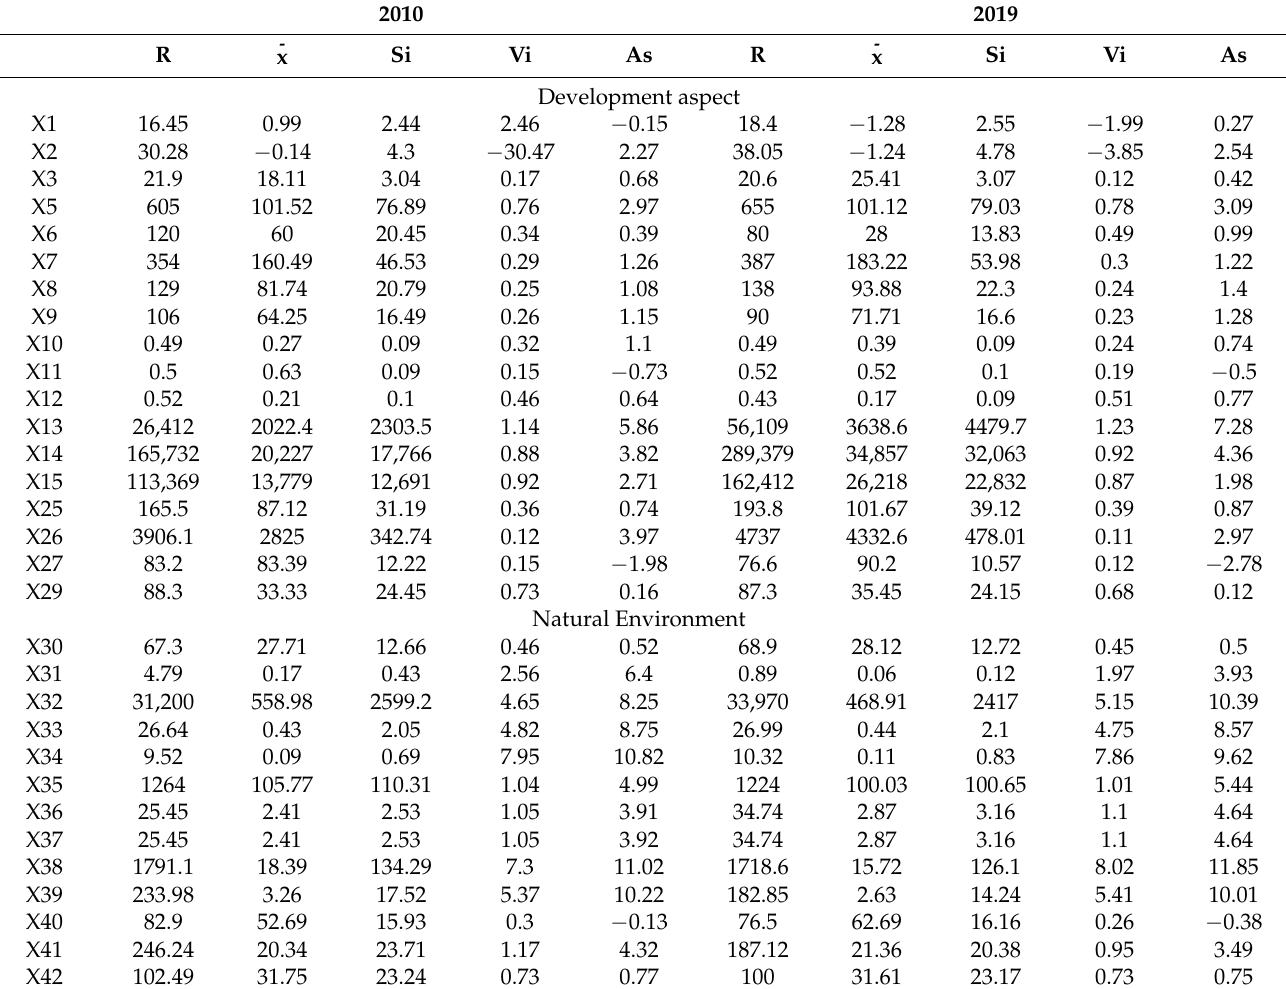
Table 2. Statistical characteristics of diagnostic variables of Polish poviats in 2010 and